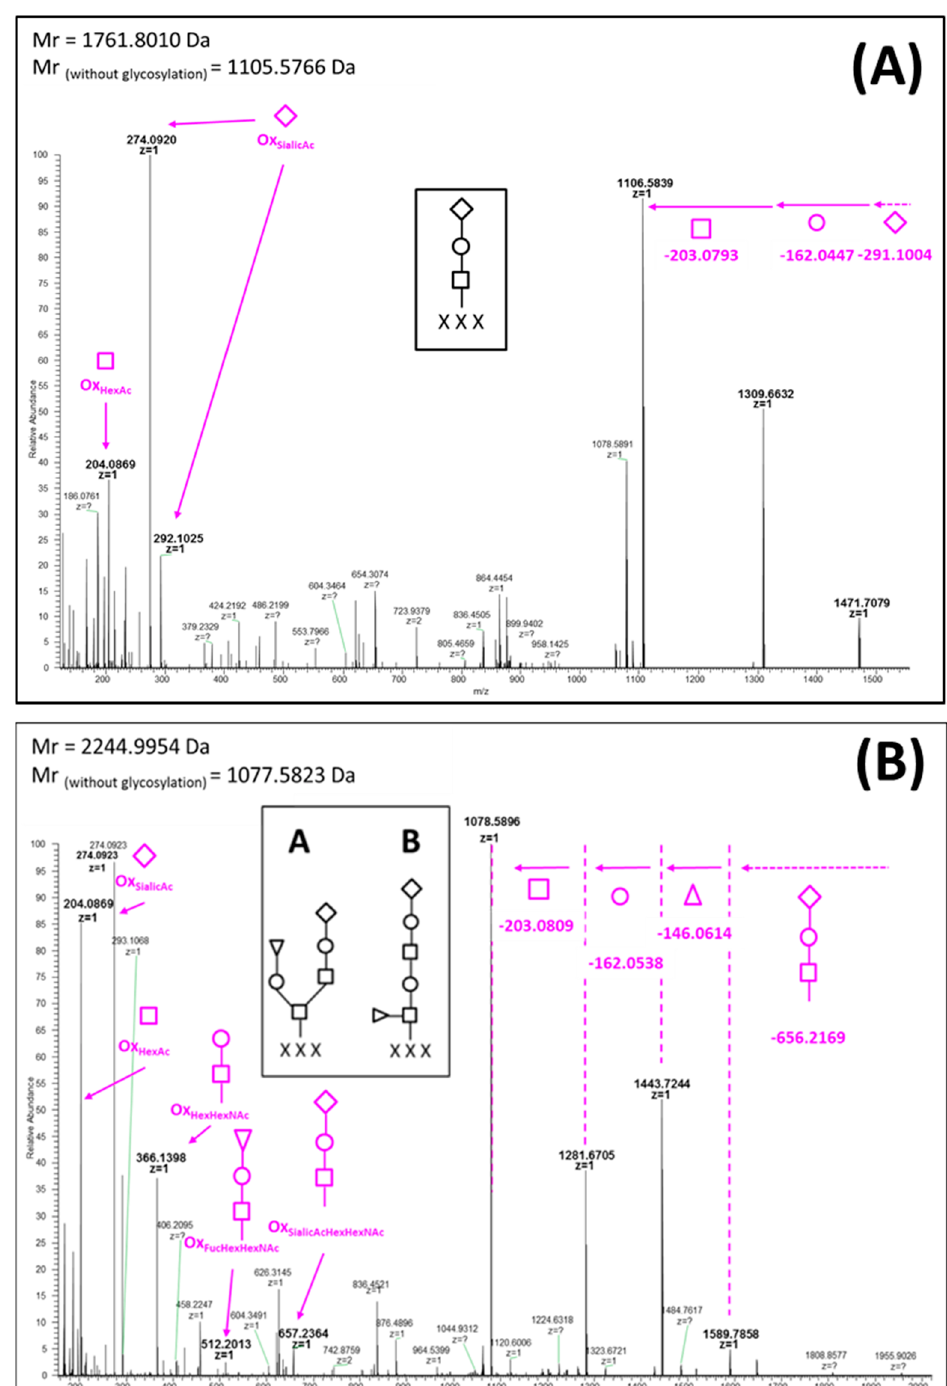
Figure 2. NUPLC-MS/MS spectra of peptide bearing O -glycans containing ( A ) sialic acid and ( B ) fucose. Carbohydrates are represented by the nomenclature proposed by Harvey et al. [13]. Oxonium ions are flagged by arrows.